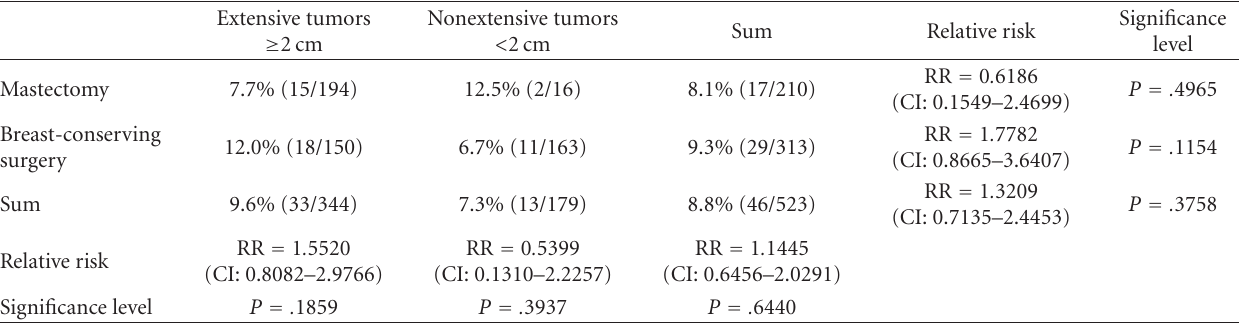
Table 3: Ipsilateral local recurrence rates by disease extent and type of surgery: extensive tumors defined as those occupying an area 2cm or larger in the greatest dimension. Falun 1996–1998, 10-year